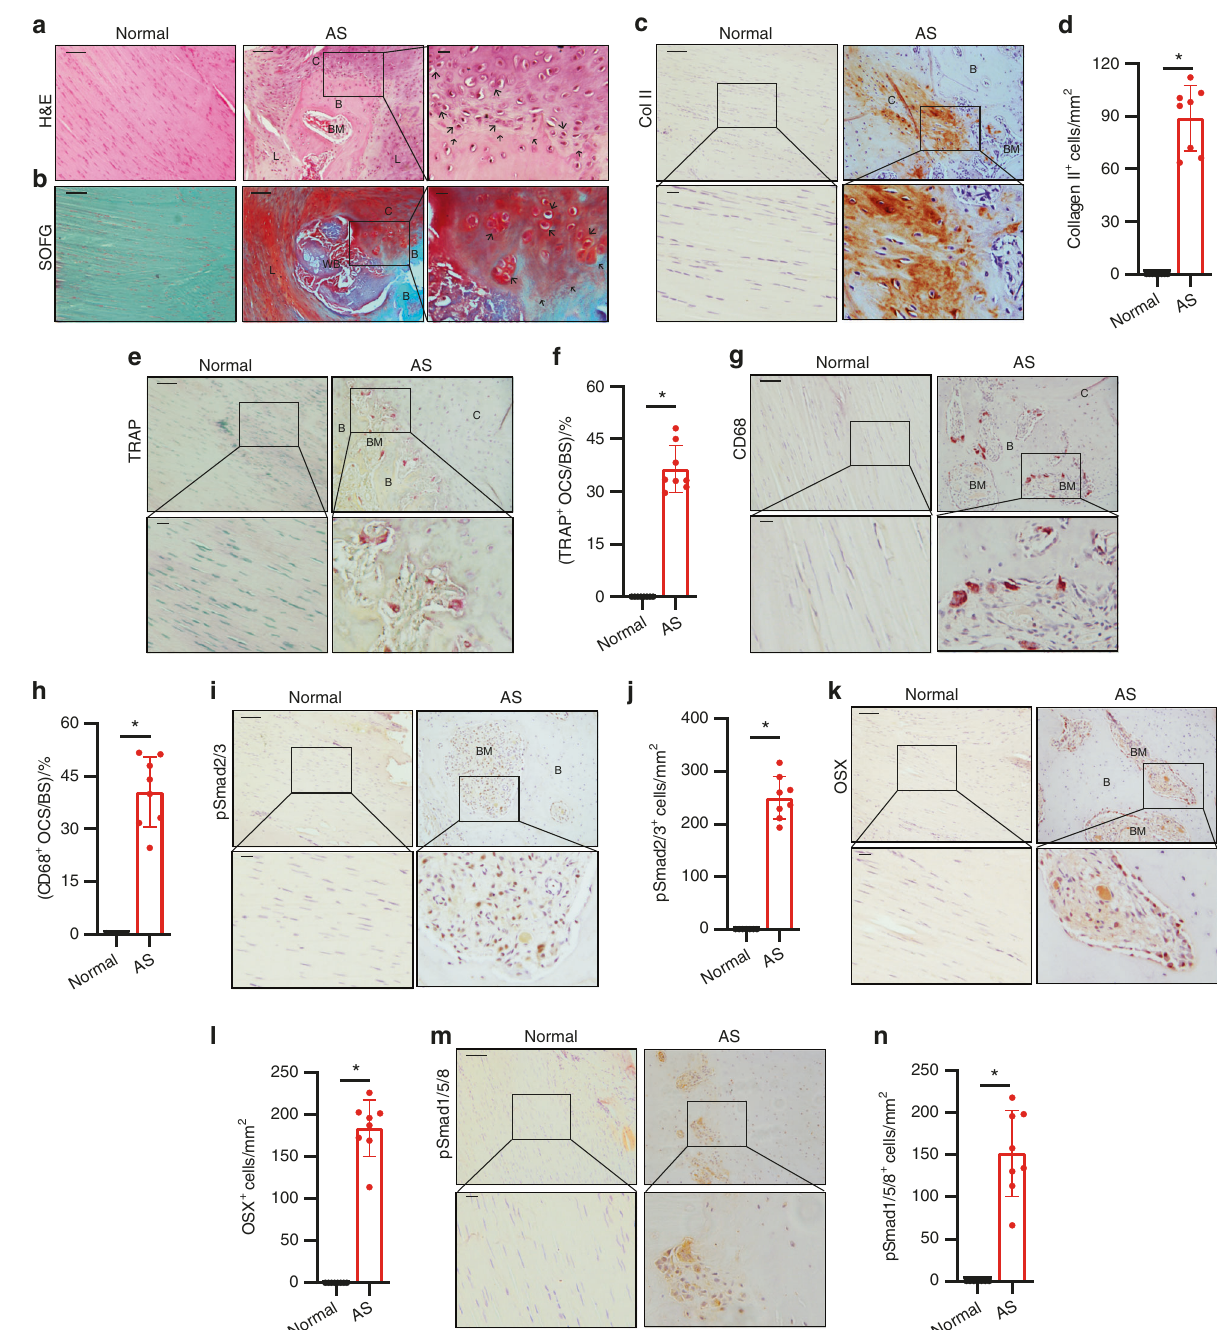
Fig. 4 Progression of endochondral heterotopic ossi fi cation in AS patients. a Hematoxylin and eosin (H&E) staining and b Safranin O – Fast Green (SOFG) staining of normal interspinous ligaments and endochondral-ossi fi ed interspinous ligaments. In the AS group, the right panels show magni fi ed views of the boxed area in the left panels. Scale bar: 100 μ m (two panels on the right side); 25 μ m (left panel). c Immunostaining and d quantitative analysis of collagen II-positive cells (brown) in the normal and chondrogenic interspinous ligaments (sagittal view). The bottom panels show magni fi ed views of the boxed area in the top panels. Scale bar: 100 μ m (top panels); 25 μ m (bottom panels). e Tartrate-resistant acid phosphatase (TRAP)-positive cells (red) and f quantitative analysis of TRAP-positive osteoclast (red) surface (OCS) per bone surface (BS). The bottom panels show magni fi ed views of the boxed area in the top panels. Scale bar: 100 μ m (top panel); 25 μ m (bottom panel). g Immunostaining and h quantitative analysis of the number of CD68-positive osteoclast (brown) surface (OCS) per bone surface (BS). The bottom panels show magni fi ed views of the boxed area in the top panels. Scale bar: 100 μ m (top panel); 25 μ m (bottom panel). i Immunostaining and j quantitative analysis of pSmad2/3-positive cells (brown) in the normal ligaments and endochondral-ossi fi ed interspinous ligaments (sagittal view). The bottom panels show magni fi ed views of the boxed area in the top panels. Scale bar: 100 μ m (top panel); 25 μ m (bottom panel). k Immunostaining and l quantitative analysis of Osterix-positive cells (brown) in the normal and endochondral- ossi fi ed interspinous ligaments (sagittal view). The bottom panels show magni fi ed views of the boxed area in the top panels. Scale bar: 100 μ m (top panel); 25 μ m (bottom panel). m Immunostaining and n quantitative analysis of pSmad1/5/8-positive cells (brown) in the normal and in fl ammatory interspinous ligaments (sagittal view). The bottom panels show magni fi ed views of the boxed area in the top panels. Scale bar: 100 μ m (top panels); 25 μ m (bottom panels). B, bone; BM, bone marrow; C,